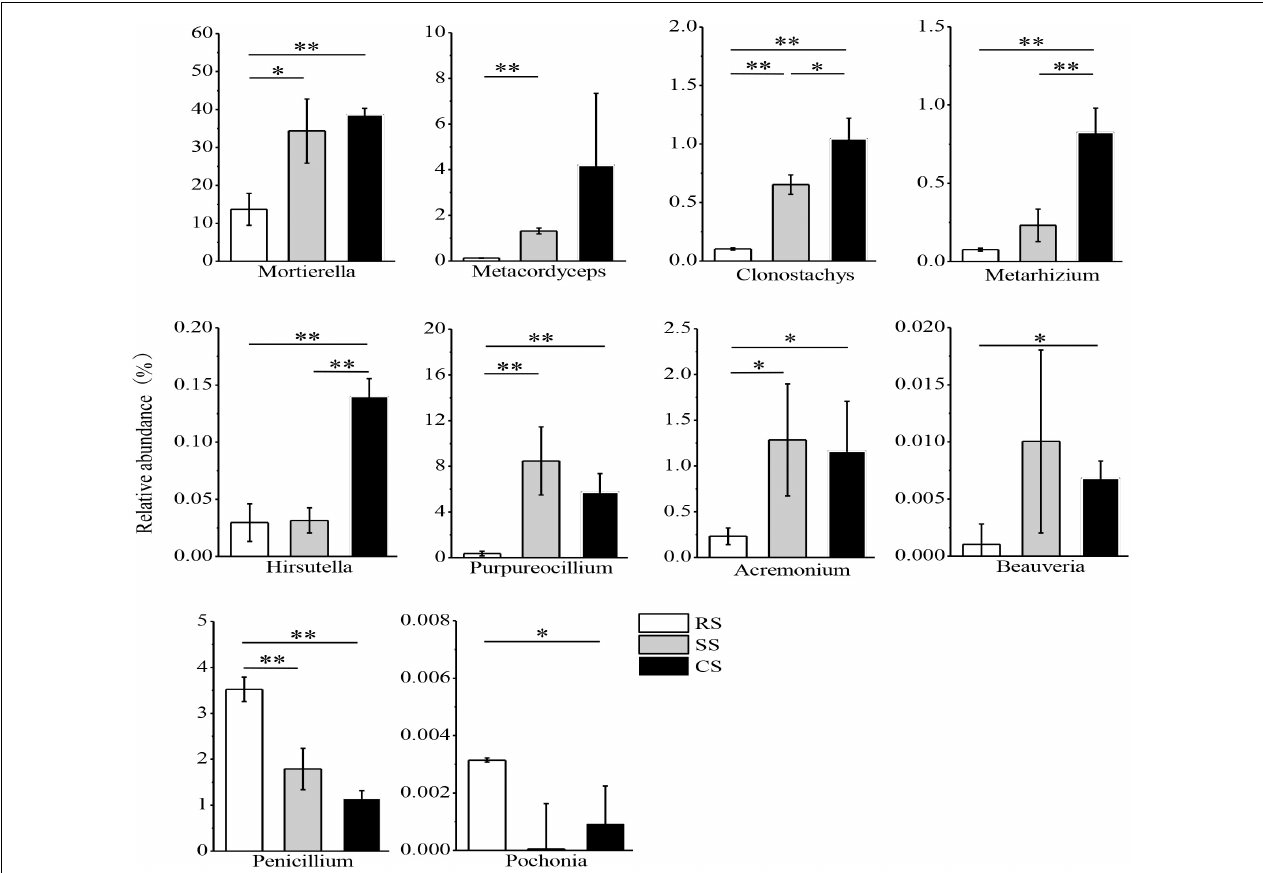
FIGURE 7 | Relative abundance of potentially beneficial fungi in three soybean cropping systems. ∗ P < 0.05, ∗∗ P < 0.01 by Student’s t -test (equal variance). RS, SS, and CS represented soybean rotation with a 3-year cycle of wheat, maize and soybean, short-term continuous soybean cropping with 1-year wheat and 2-year soybean, and long-term continuous soybean cropping,